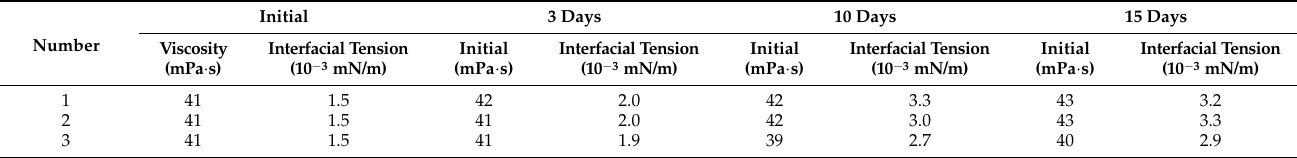
polymer solution, and there would be no significant impact when the two were mixed and injected. Affect the properties of the polymer solution. Table 6. Viscosity and interfacial tension changes in particle solutions and polymer solutions.